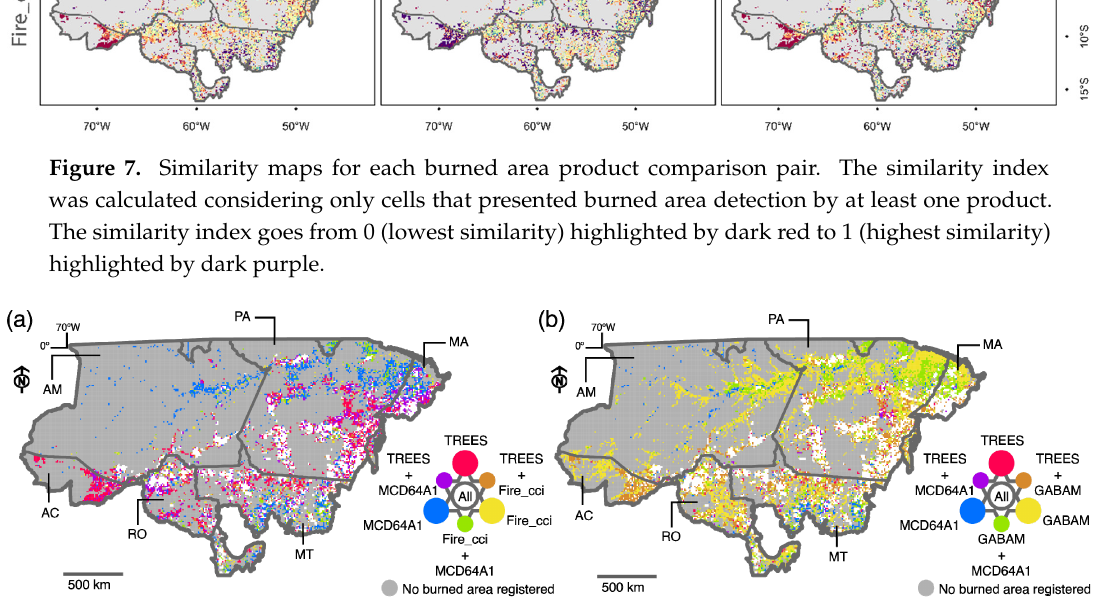
Figure 8. Confusion maps considering ( a ) TREES, MCD64A1 and Fire_cci burned area products, and ( b ) TREES, MCD64A1 and GABAM burned area products. The 10km cells are colored according to the occurrence of information from each product or a combination of them, disregarding the burned area proportion in each cell.